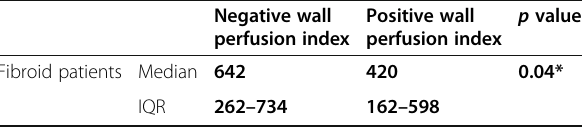
Table 2 Comparison between the perfusion indices in the positive and negative walls in the fibroid